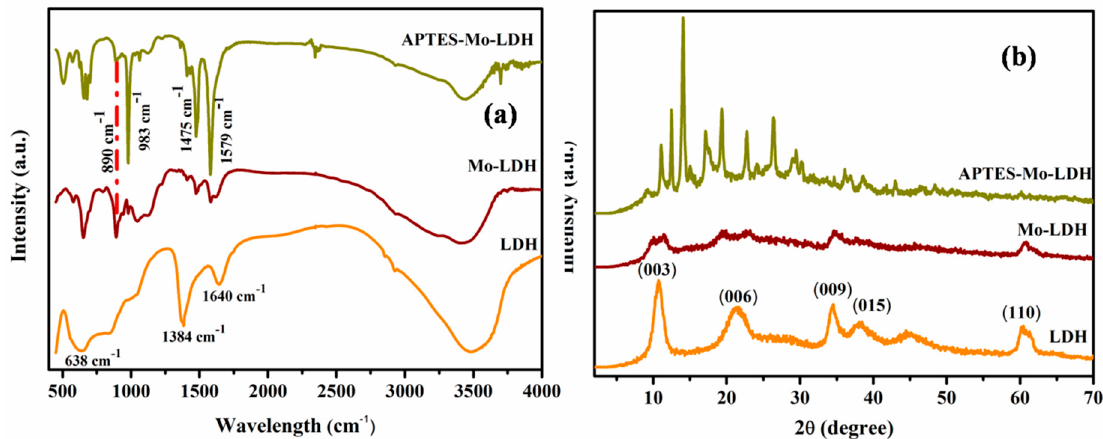
Figure 2. ( a ) Fourier-transform infrared (FTIR) spectra and ( b ) X-ray diffraction (XRD) pattern of